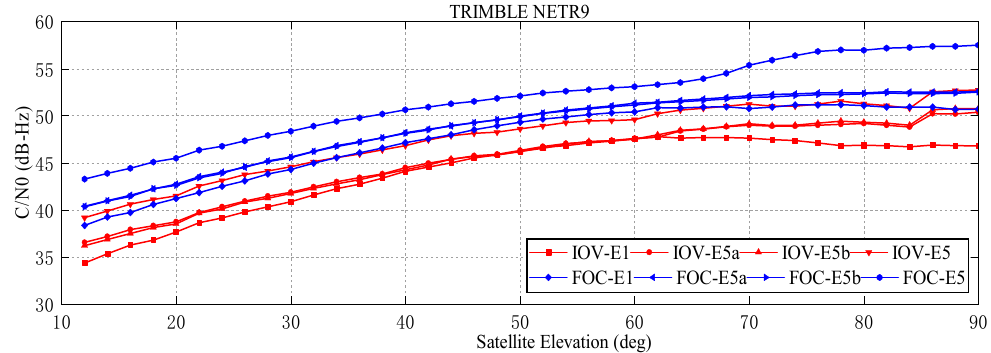
Figure 5. C/N0 values of the different types of satellites against the satellite elevation for the receiver TRIMBLE NETR9.